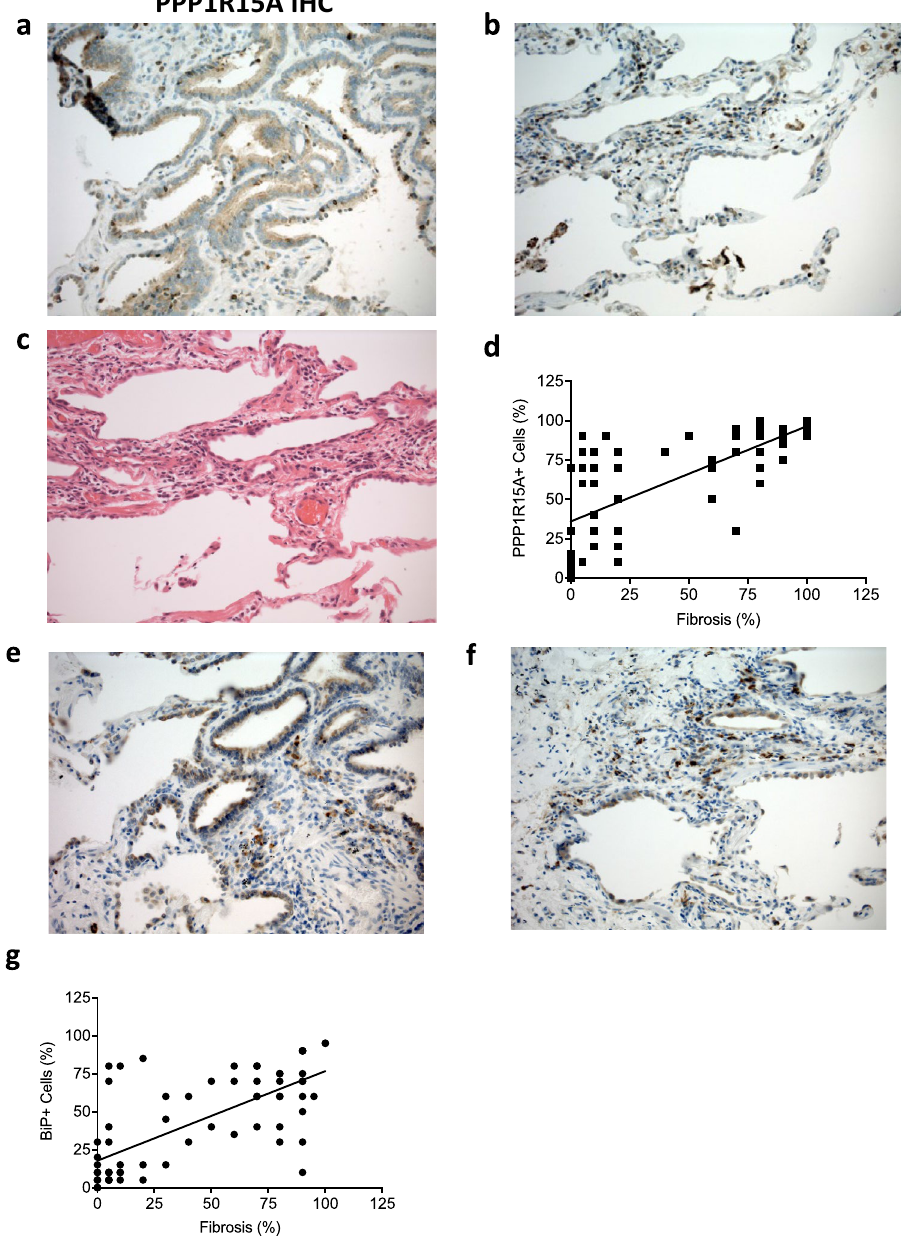
Figure 2. Immunolocalisation of ER stress markers. PPP1R15A ( a , b ) and BiP ( e , f ) in IPF human lung tissue and correlation of number of positive cells with extent of fibrosis. Representative images obtained using light microscopy (× 200 magnification) stained with rabbit polyclonal anti-PPP1R15A ( a , b ), haematoxylin and eosin ( c ), anti-BiP ( e , f ) shown. Correlation of PPPIR15A ( d , r 2 = 0.289, P < 0.001) and BiP ( g , r 2 = 0.408, P < 0.001) with extent of fibrosis in 4 UIP patients using semi-quantitative analysis in six high powered fields randomly selected by 2 blinded independent investigators. Data were analysed by linear